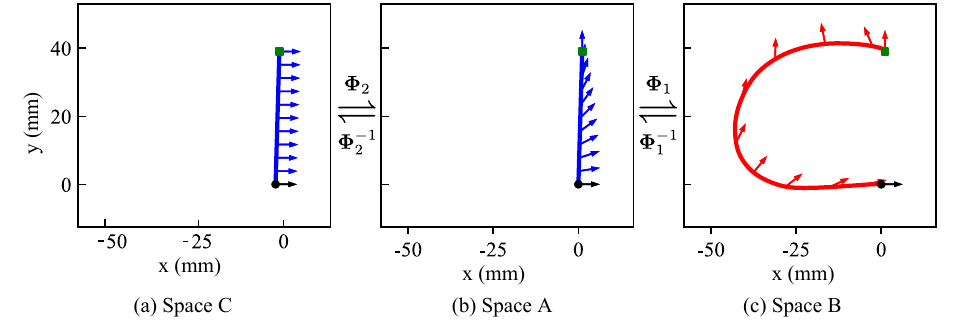
Figure 3. The trajectories in the different